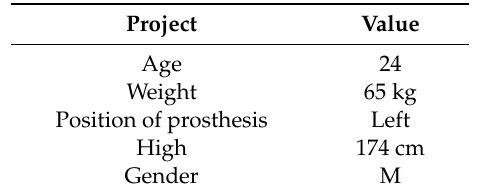
Figure 14. The structure and process of the classifier. As different orders and feature vectors are needed to classify walk, upstairs and dwstairs, one can distinguish walk and dwstairs first, and then separate upstairs from walk and dwstairs, respectively, then separate upstairs from walk and Table 6. Information of the subject. dwstairs, respectively.